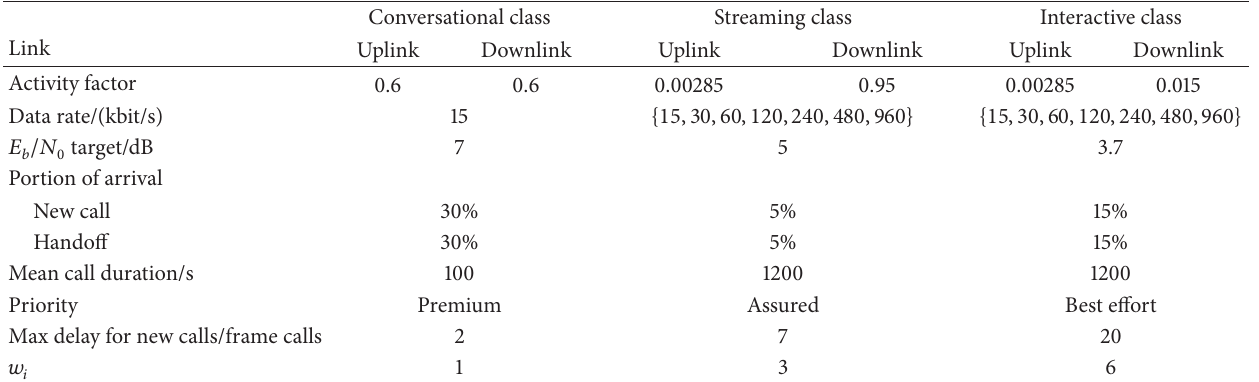
Table 1: Traffic